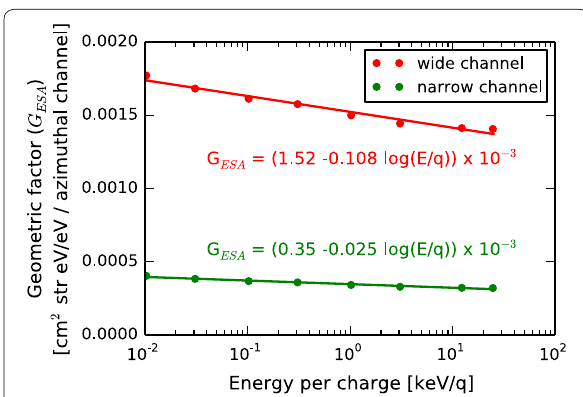
Fig. 5 The geometric factor ( G ESA ) for wide (red) and narrow (green) channels. The lines are obtained by the least square